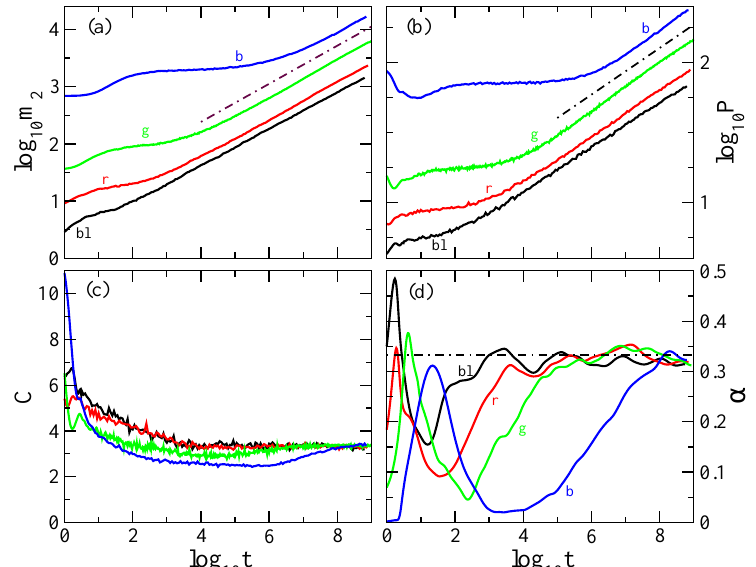
Figure 3: Density resolved weak chaos wave packet spreading. h = 0, a < d . (a) ( t ) vs. log m t . Dashed dotted line: m log 2 10 10 Dashed dotted line: P ( t ) ∼ t 1 / 6 . (c) C vs. log α = 1 / 3. The parameters are: a = 0.0025 and W = 2 for (b)lue line, a = 0.05 and W = 4 for (g)reen line, a = 0.245 and W = 6 for (r)ed line, a = 0.9 and W = 8 for (bl)ack line. The system size N = 2 10 , the number of disorder realizations is